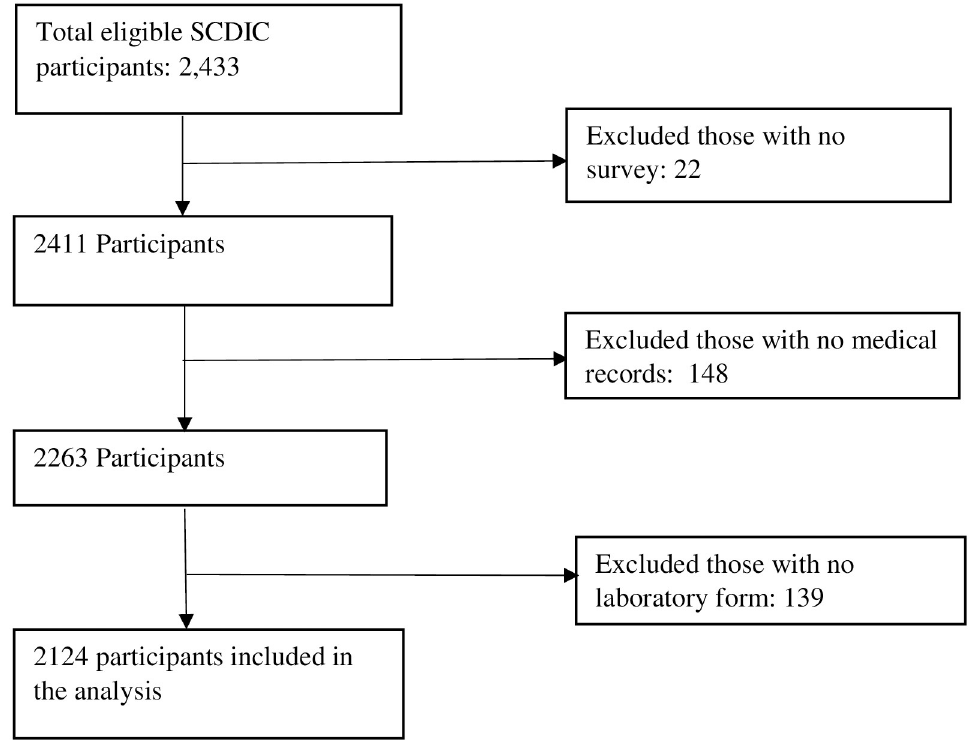
Fig 1. Flow diagram of participant